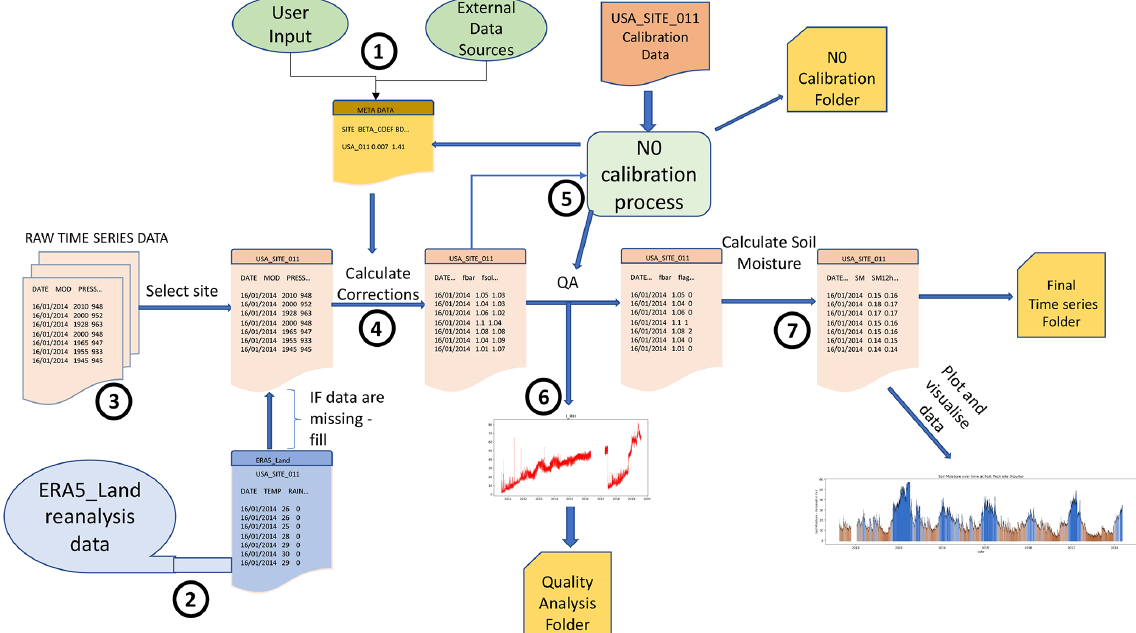
Figure 1. The structure of crspy, demonstrating all of the modules that are used in creating soil moisture estimates. Number 1 represents the metadata table, which is a collection of site descriptors, e.g. soil texture and site elevation (see Sect. 2.4). Numbers 2, 3, and 4 correspond to gap filling with ERA5-Land data, data tidying, and the computation of correction factors, respectively (see Sect. 2.1). Number 5 represents the calibration process, if this option is selected (see Sect. 2.2). Number 6 highlights the quality assessment steps undertaken (see Sect. 2.3). Finally, number 7 represents the step where soil moisture estimates are calculated from the neutron counting rates (refer to Eq.